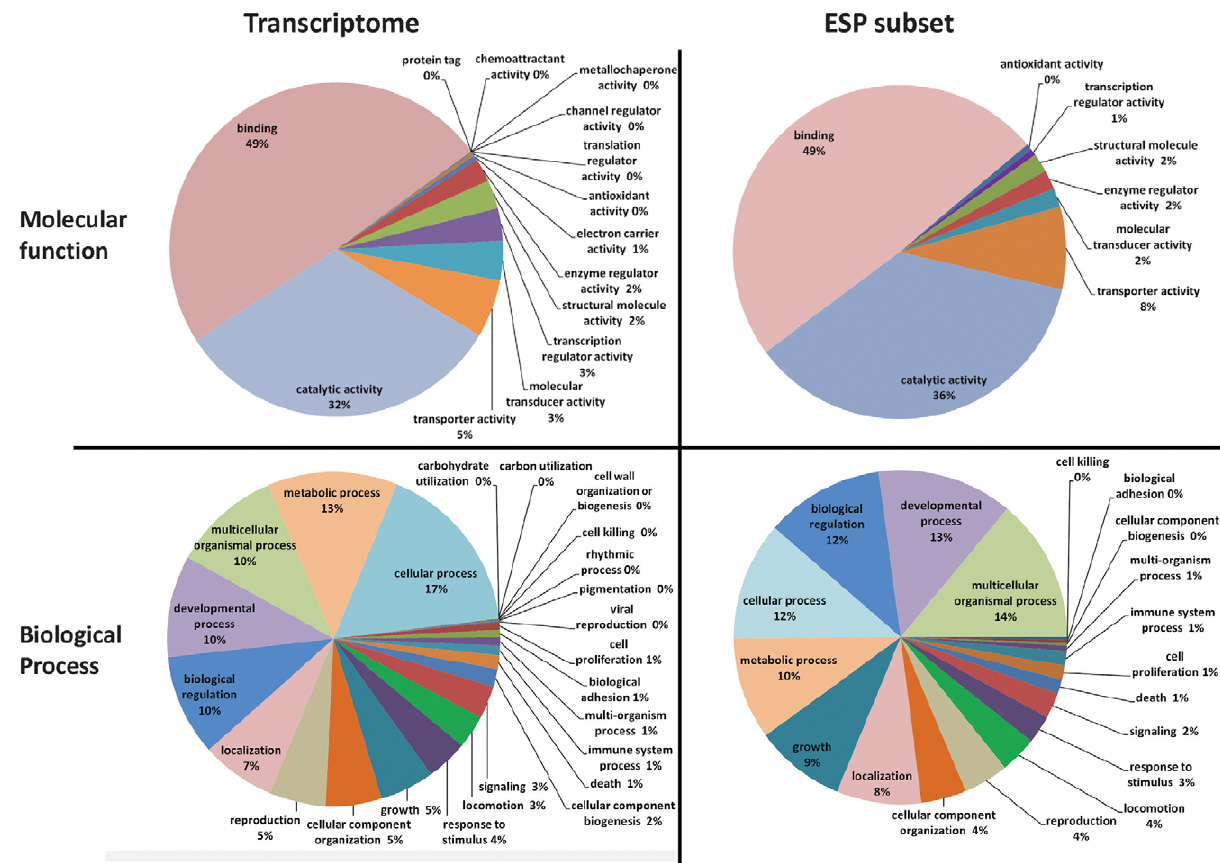
Figure 1. Molecular function and biological process GO terms (level 2) for the transcriptome and ESP subset.